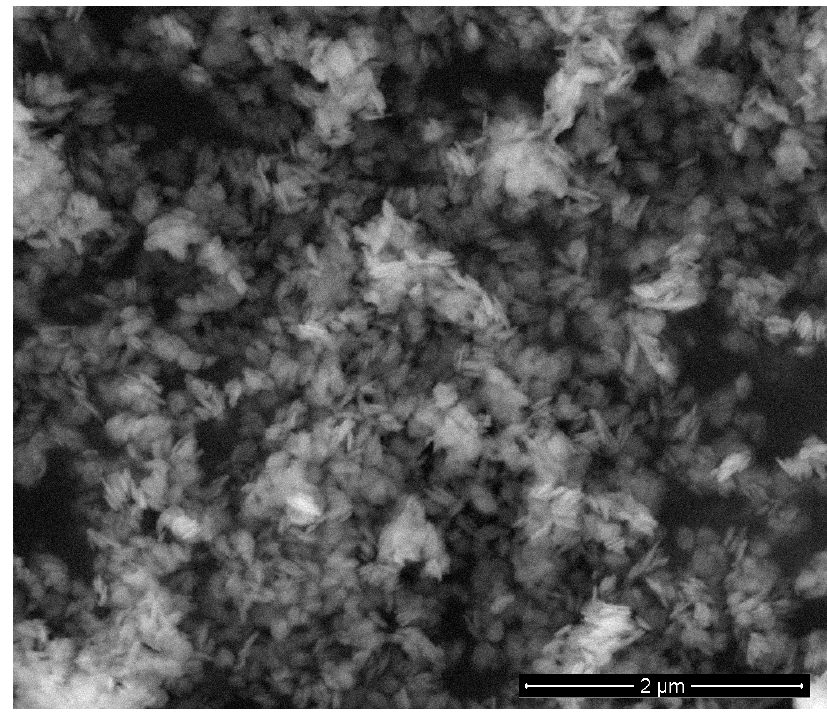
Figure 2. SEM images of Co 3 O 4 powder sample annealed at 200 °C in air.